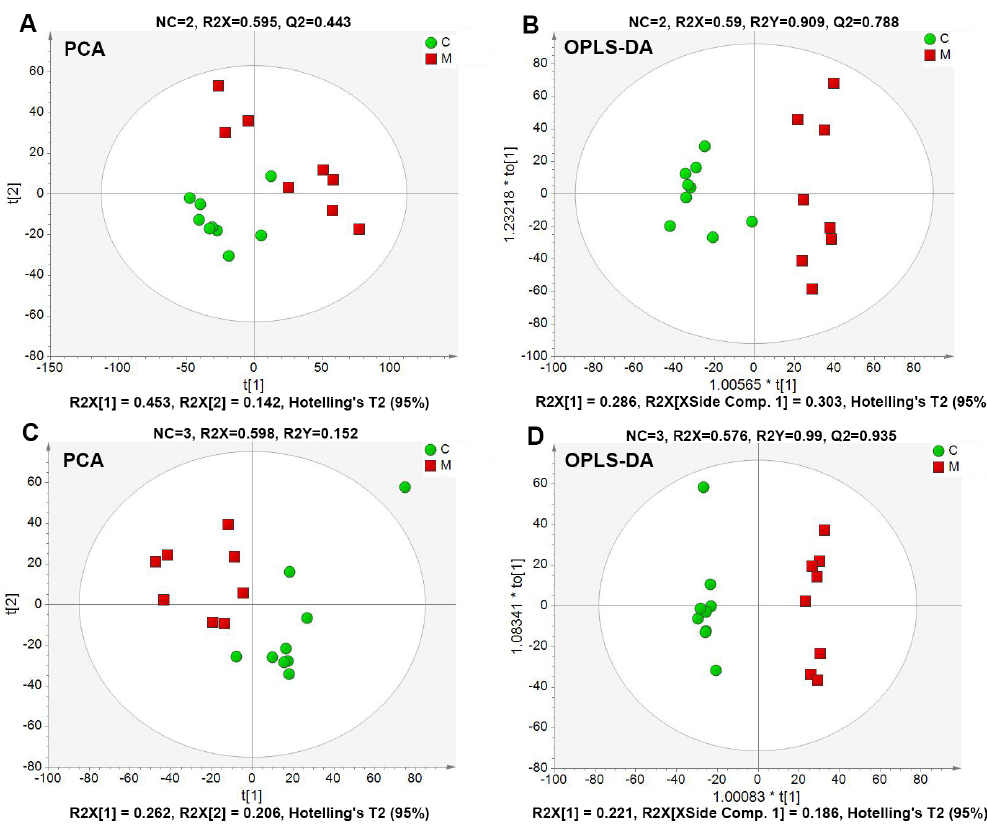
Figure 4. PCA and OPLS-DA score plots derived from UPLC-Q/TOF-MS profiling of the sera metabolomics of control and model groups. ESI + mode: ( A , B ); ESI − mode: ( C , D ); NC represented the number of components. R2X and R2Y were cumulative variation of all R2Xs and R2Ys, separately. Q2 was the cumulative predicted fraction. p CV-ANOVA values for OPLS-DA models ( B , D ) were 5.20008 × 10 − 4 and 2.14075 × 10 − 5 , respectively.